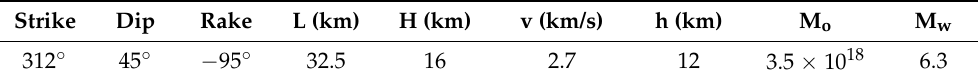
Table 2. Best fit model parameters for the fault plane. L: fault length, H: depth of faulting, v: rupture velocity, h: focal depth of centroid, M o : seismic moment (N*m), M w : moment magnitude. Dip direction of the fault is to northeast, rake is calculated at the main slip patch of the fault (see text). Strike Dip Rake L (km) H (km) v (km/s) h (km) M o M w 312 ◦ 45 ◦ − 95 ◦ 32.5 16 2.7 12 3.5 × 10